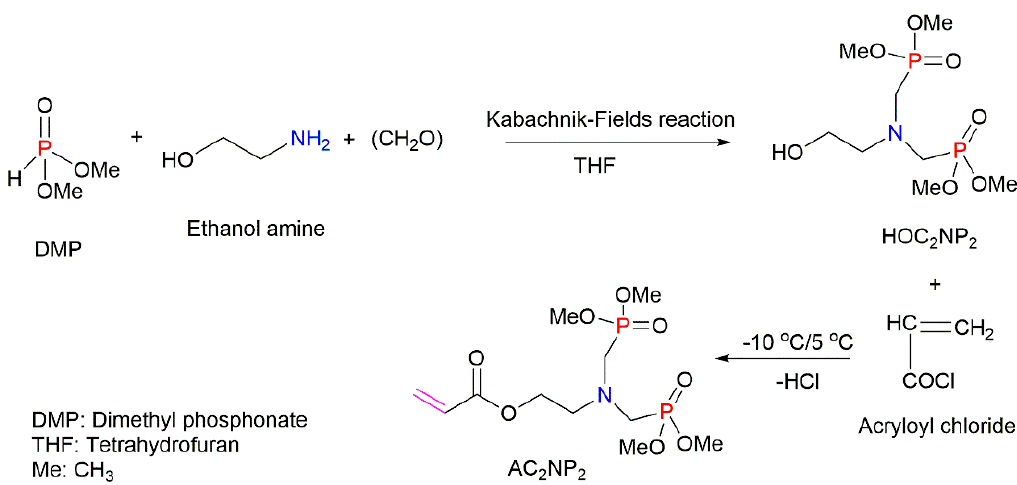
Figure 25. The Kabachnik–Fields reaction to synthesise ethyl- N,N -tetramethyl-bis(phosphonate)- bis(methylene)amine acrylate (AC 2 NP 2 ) [107,119].